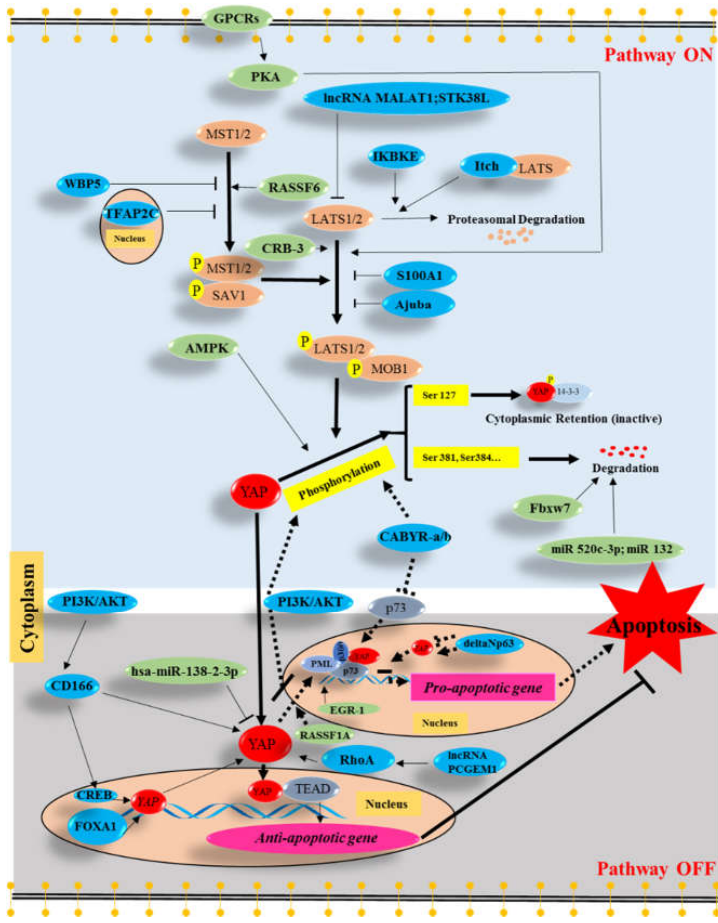
Figure 3. Many molecules regulate apoptosis and Hippo-YAP signaling pathway. Anti-apoptotic molecules are indicated in blue, whereas pro-apoptotic molecules are indicated in green. Most anti-apoptotic molecules, such as metastasis associated lung adenocarcinoma transcript 1 (MALAT1), serine/threonine kinase 38 like (STK38L), inhibitor of nuclear factor kappa B kinase subunit epsilon (IKBKE), Itch, S100 calcium-binding protein A1 (S100 A1), Ajuba, transcription factor AP-2 Gamma (TFAP2C), WW domain binding protein 5 (WBP5), lncRNA PCGEM1, Ras homolog gene family,